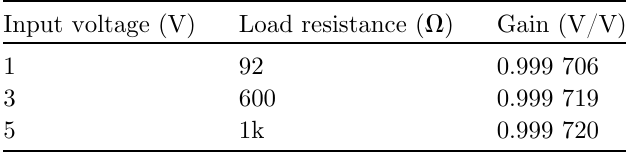
Fig. 2. Simulation results from the optimized buffer model. The top graph is the simulation of error in dc gain linearization according to equation (2). The bottom graph is the simulation of ac gain deviation from 10Hz for 1 V, 3 V and 5 V input voltage with loads equal to the TCs used in equivalent measurements of ac – dc difference. Table 1. Simulated ac gain at 10 Hz of the voltage buffer for the three cases of 1 V, 3 V and 5 V input